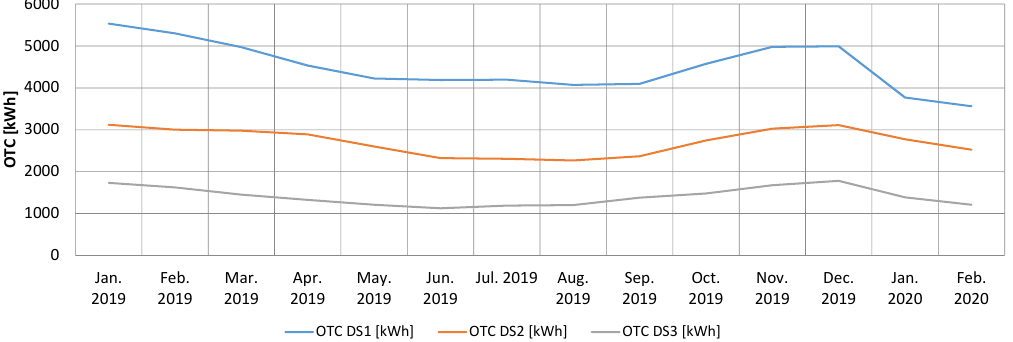
Figure 6. OTC evolution for January2019–February 2020 per individual